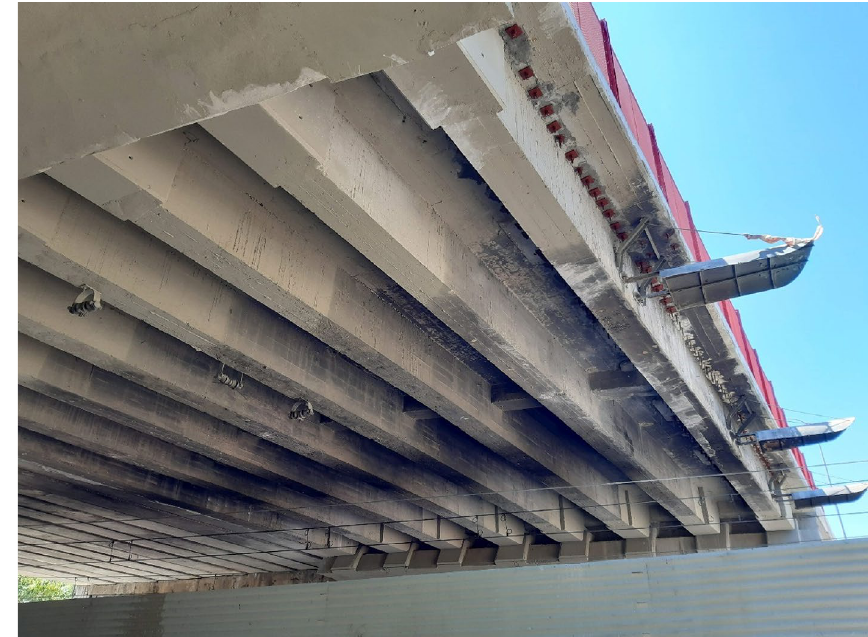
Figure 8. Road bridge analyzed.